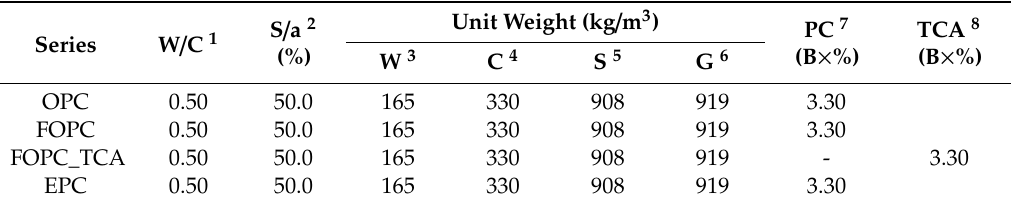
Table 3. Mixing proportions of concrete.